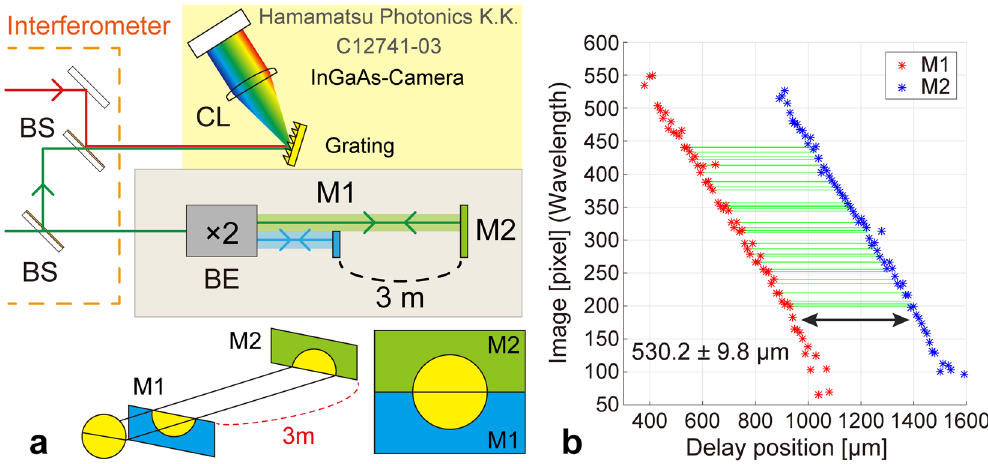
Figure 6. Schematic and results of the large step measurement. ( a ) Experimental setup for the large step measurement. The interferometer setup is same as that shown in Fig. 2a. ( b ) Series of minimum fringe frequencies obtained for the two m-sized separated